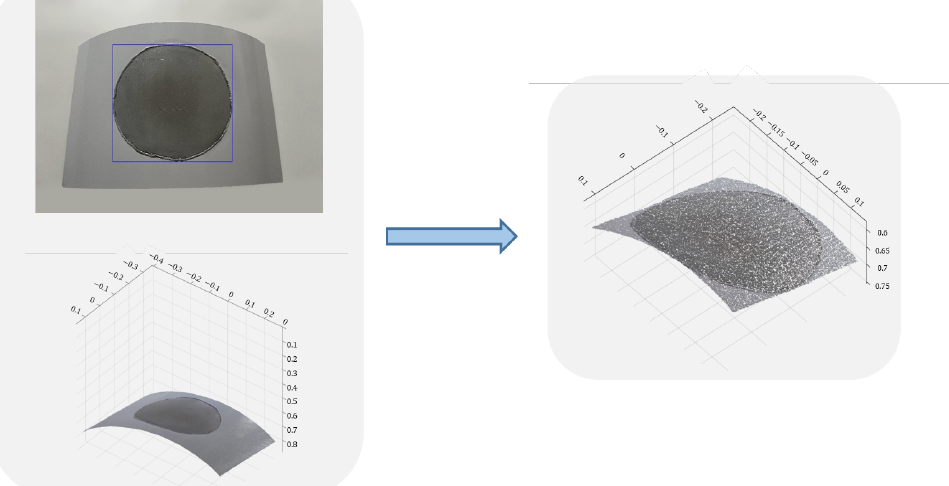
Figure 6. 2D image mapping 3D point